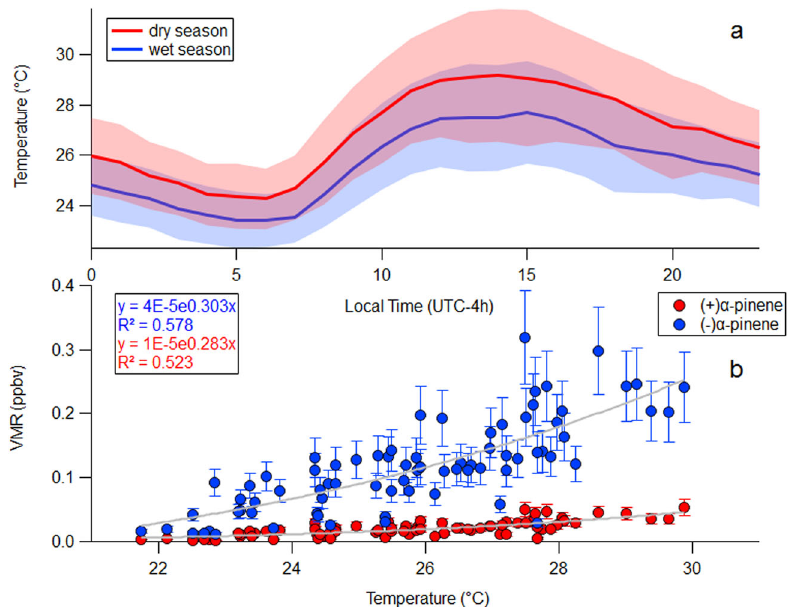
Fig. 6 Temperature dependency of ( − )- α -pinene and ( + )- α -pinene volume mixing ratios at 80 m during the wet season. Equations represent the exponential fi t to ( − )- α -pinene versus T and ( + )- α -pinene vs T in the form: VMR = Aexp β (T-Ts), where A is the intercept and β the temperature sensitivity factor. Panel a shows the air temperature registered during the dry season (November 2017) and wet season (March 2018) of sampling. Error bars in panel b represent the measurement uncertainty (23%) while shaded areas in panel a represent the standard deviation of temperature dataset. Dry season mixing ratios against temperature are shown in Supplementary Fig. 6.